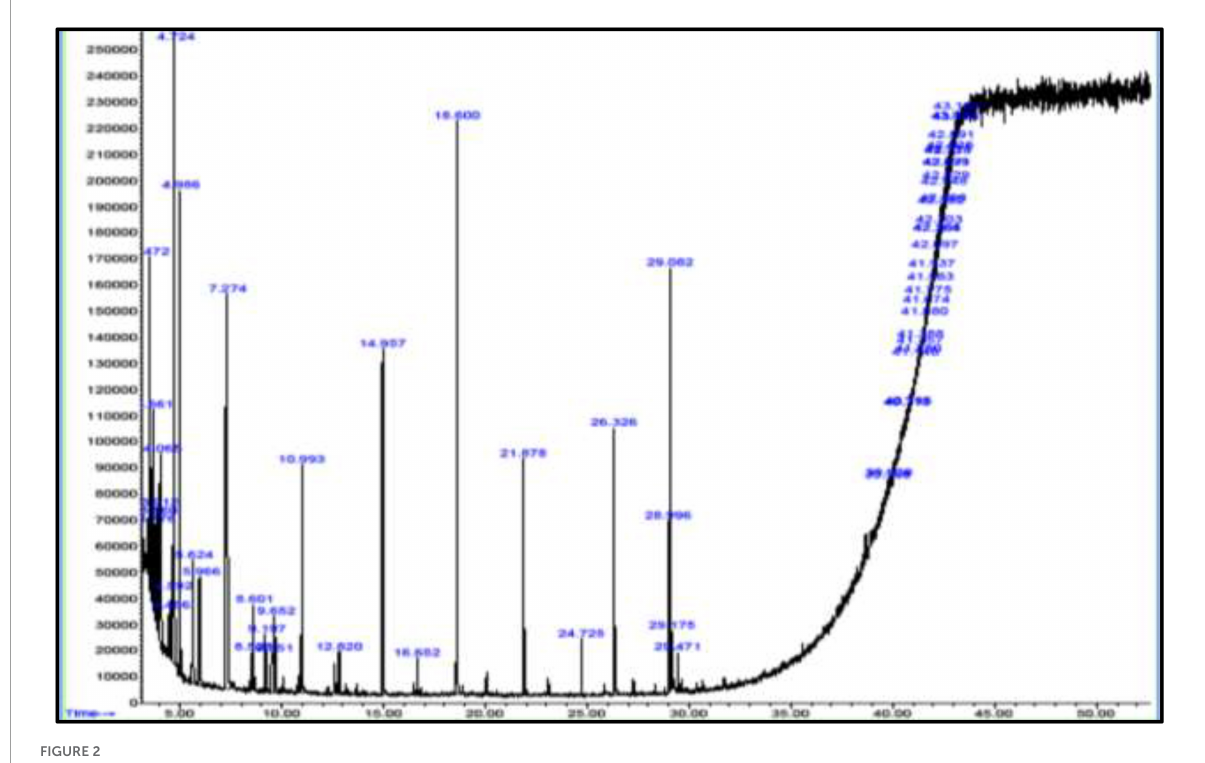
FIGURE2 GC-MS chromatogram of leaf extracts of P. dactylifera.